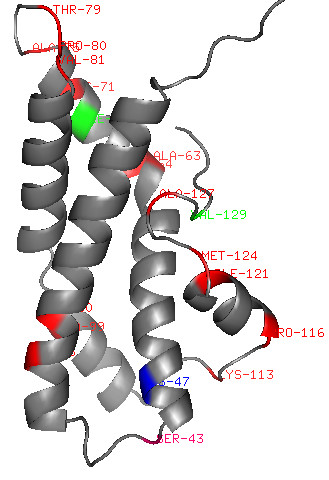
Lysin crystal structure from the red abalone Haliotis rufescens ([24], PDB ID 1ILS). Sites in color are in the (ω≥1, γ≤1) category. The site that is blue (47) from both the charge and hydrophobicity partitions. Sites that are green (69, 129) are from the hydrophobicity partition only. Sites that are red (30,33,63,64,71,75,79,80,81,99,113,116,121,124,127) are from the charge partition only. Finally, the site that is hot pink (43) is from the polarity partition only.